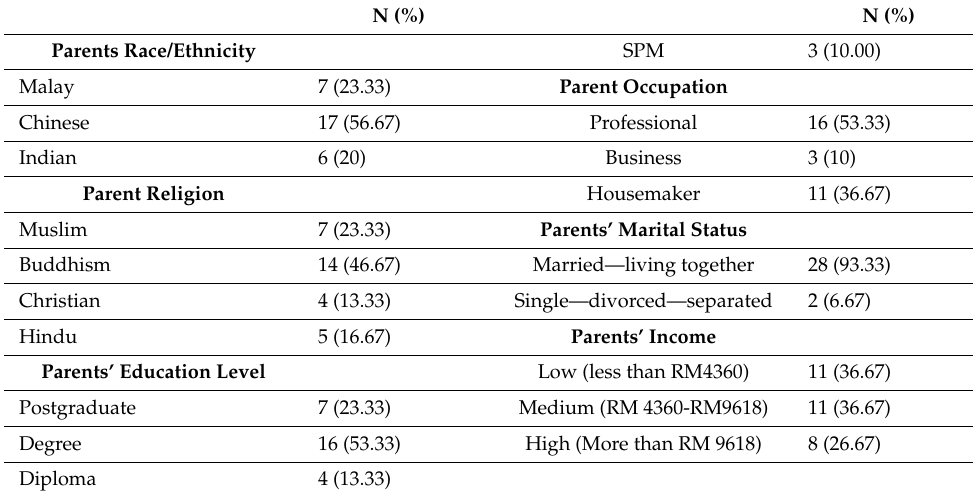
Table 2. Background information of parents ( n =